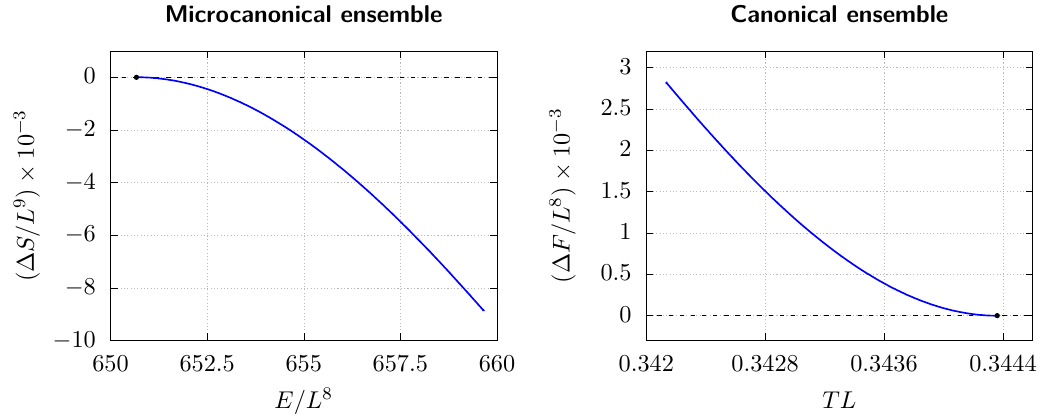
Figure 5. Phase diagram in the microcanonical ensemble (left) and canonical ensemble (right), of ‘ = 1 lumpy black holes. The GL threshold point is indicated with a black solid disc. The zero is taken to be the Schwarzschild-AdS 7 black hole phase. The lumpy black holes are subdominant 4 × S in both ensembles. The phase diagrams of the other families of lumpy black holes that we have constructed are qualitatively similar, except for the ‘ = 2 − family.